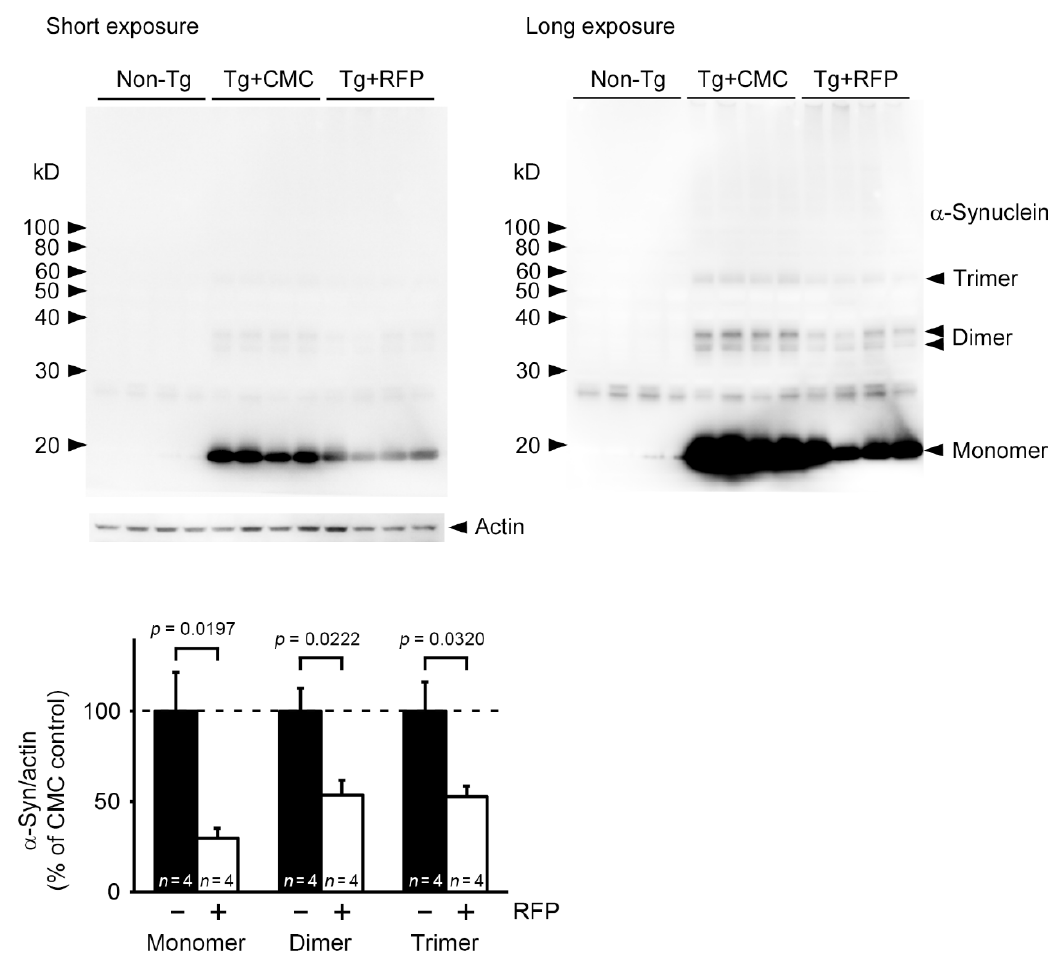
Figure 6. Clearance of α -synuclein oligomers by intranasal rifampicin (RFP). After the second Morris water maze test, brain soluble fractions were prepared and subjected to Western blot analysis. The density of visualized α -synuclein bands were quantified and compared between CMC- and rifampicin-treated Tg mice. α -Synuclein monomers, dimers, and trimers were reduced by rifampicin treatment in Tg mice. + and − mean rifampicin- and CMC-treatment, respectively.